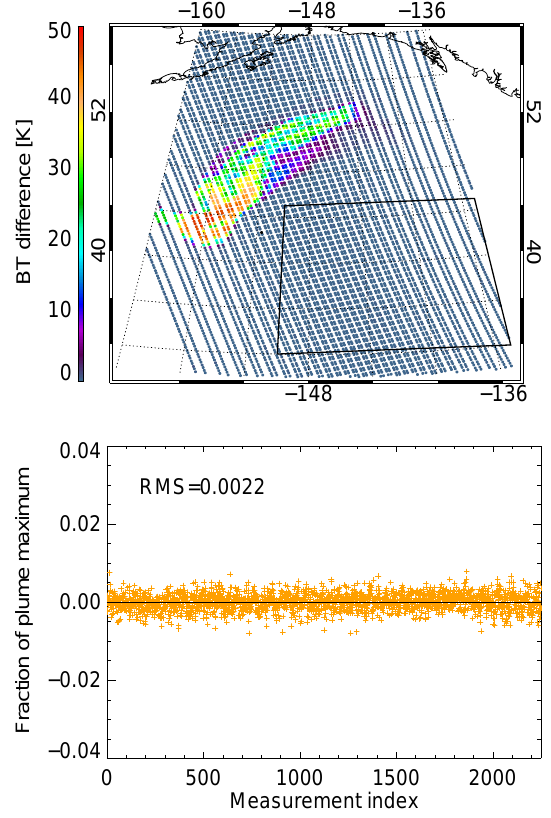
Fig. 3. Detection of SO 2 plume for the Kasatochi eruption for the morning overpass on 10 August 2008 using the four channel BTD by Clarisse et al. (2008) in terms of background channels minus SO 2 sensitive channels. The variation in the spectral back- ground within the box is shown in the bottom panel in terms of the fractional variation normalised with respect to the maximum BT value observed inside the plume (48K). Observed RMS of back-